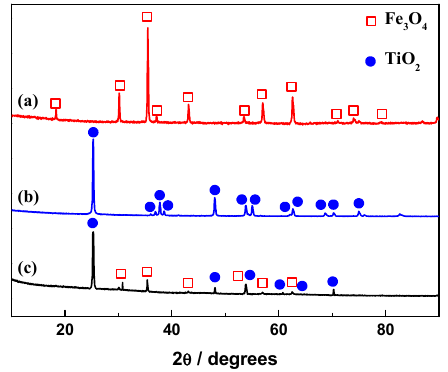
Figure 1. XRD patterns of ( a ) Fe 3 O 4 magnetic powder; ( b ) TiO 2 and ( c ) Fe 3 O 4 /TiO 2 nanocomposite.